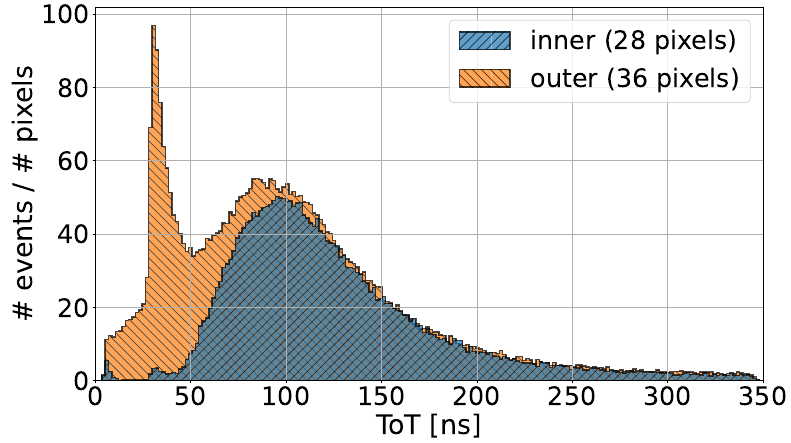
Figure 11. ToT spectrum of the seed pixels for the inner and outer region of the 10µm pitch matrix, normalized to one